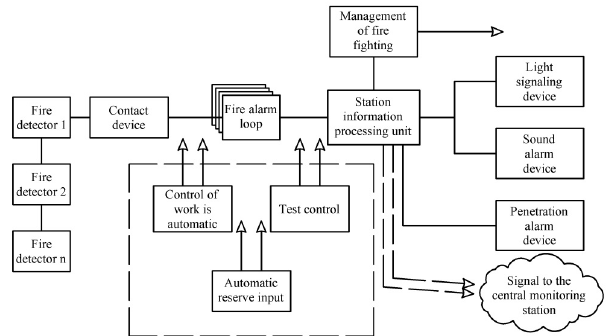
Figure 2. Generalized block diagram of a non-